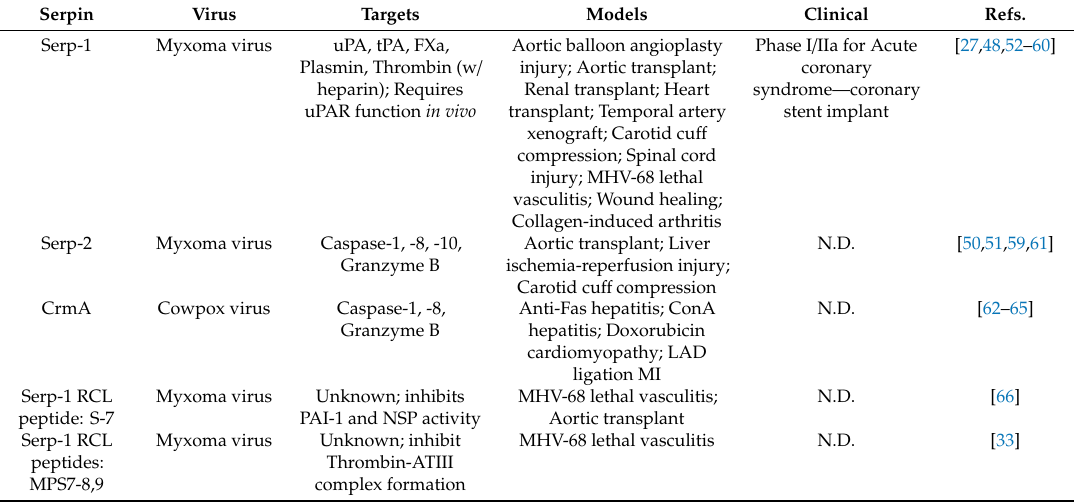
Table 1. Viral Serpins and Serpin-derived Peptides with therapeutic e ffi